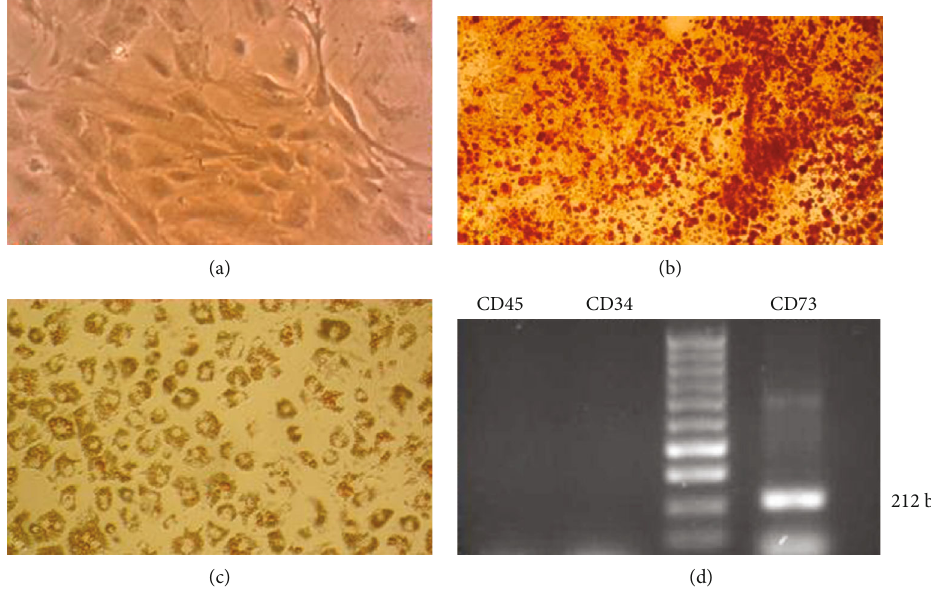
Figure 3: Characterization of rabbit bone marrow-derived mesenchymal stromal cells (BM-MSCs). (a) Fibroblast-like and spindle-shaped morphology of rabbit BM-MSCs, a typical characteristic of MSCs in passage 3 ( × 400). (b) BM-MSCs of rabbits cultivated in osteogenic medium and stained with Alizarin red ( × 100). (c) BM-MSCs of rabbits cultivated in adipogenic medium and stained with oil red O at day 21 after induction ( × 200). (d) Agarose gel electrophoresis of products of reverse transcriptase polymerase chain reaction (RT-PCR) of BM-MSCs revealing to be positive for CD73 (mesenchymal marker) and negative for CD34 and CD45 (hematopoietic markers).